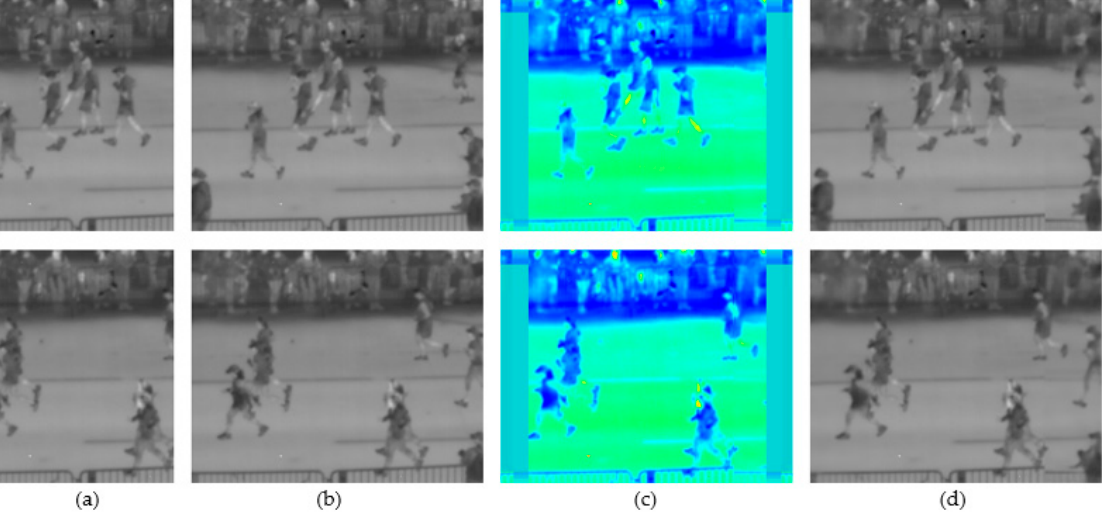
Figure 13. Comparisons of original images, GT images, and the prediction results obtained by the state-of-the-art methods and the proposed method: ( a ) original images, ( b ) GT images, and images predicted by ( c ) pred3-chan [14] and ( d ) the proposed method.